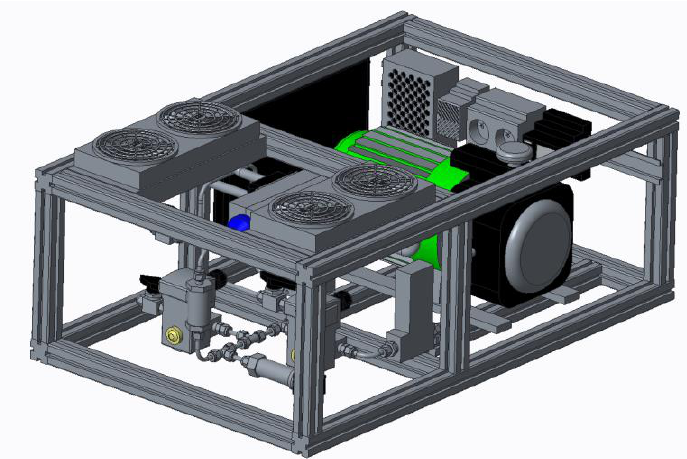
Figure 2. 3-D model of a device with a separator using metal hydride alloys.